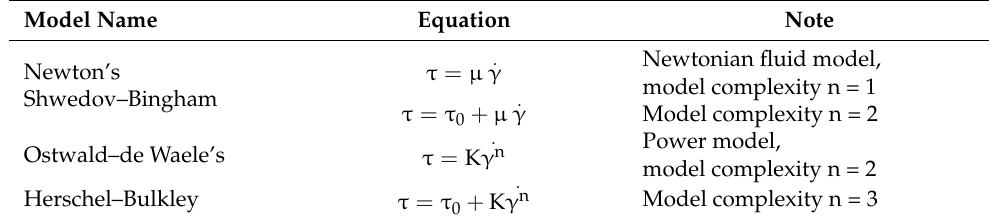
Table 3. Rheological models of non-Newtonian fluid